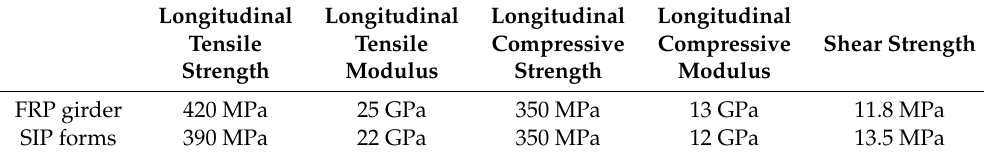
Figure 1. Illustration of a push-out test specimen (unit in mm): ( a ) Half cross section of specimens S-1,2; ( b ) Half cross section of specimens S-3,4; ( c ) Half illustration of vertical cross section of S-2; ( d ) Half illustration of vertical cross section of S-4 (note that ‘Sym’ denotes the ‘symmetric line’); ( e ) Schematic graph of push-out test of specimen S-2; and ( f ) Cross section of the FRP segment. Table 2. Material properties of the FRP profiles.